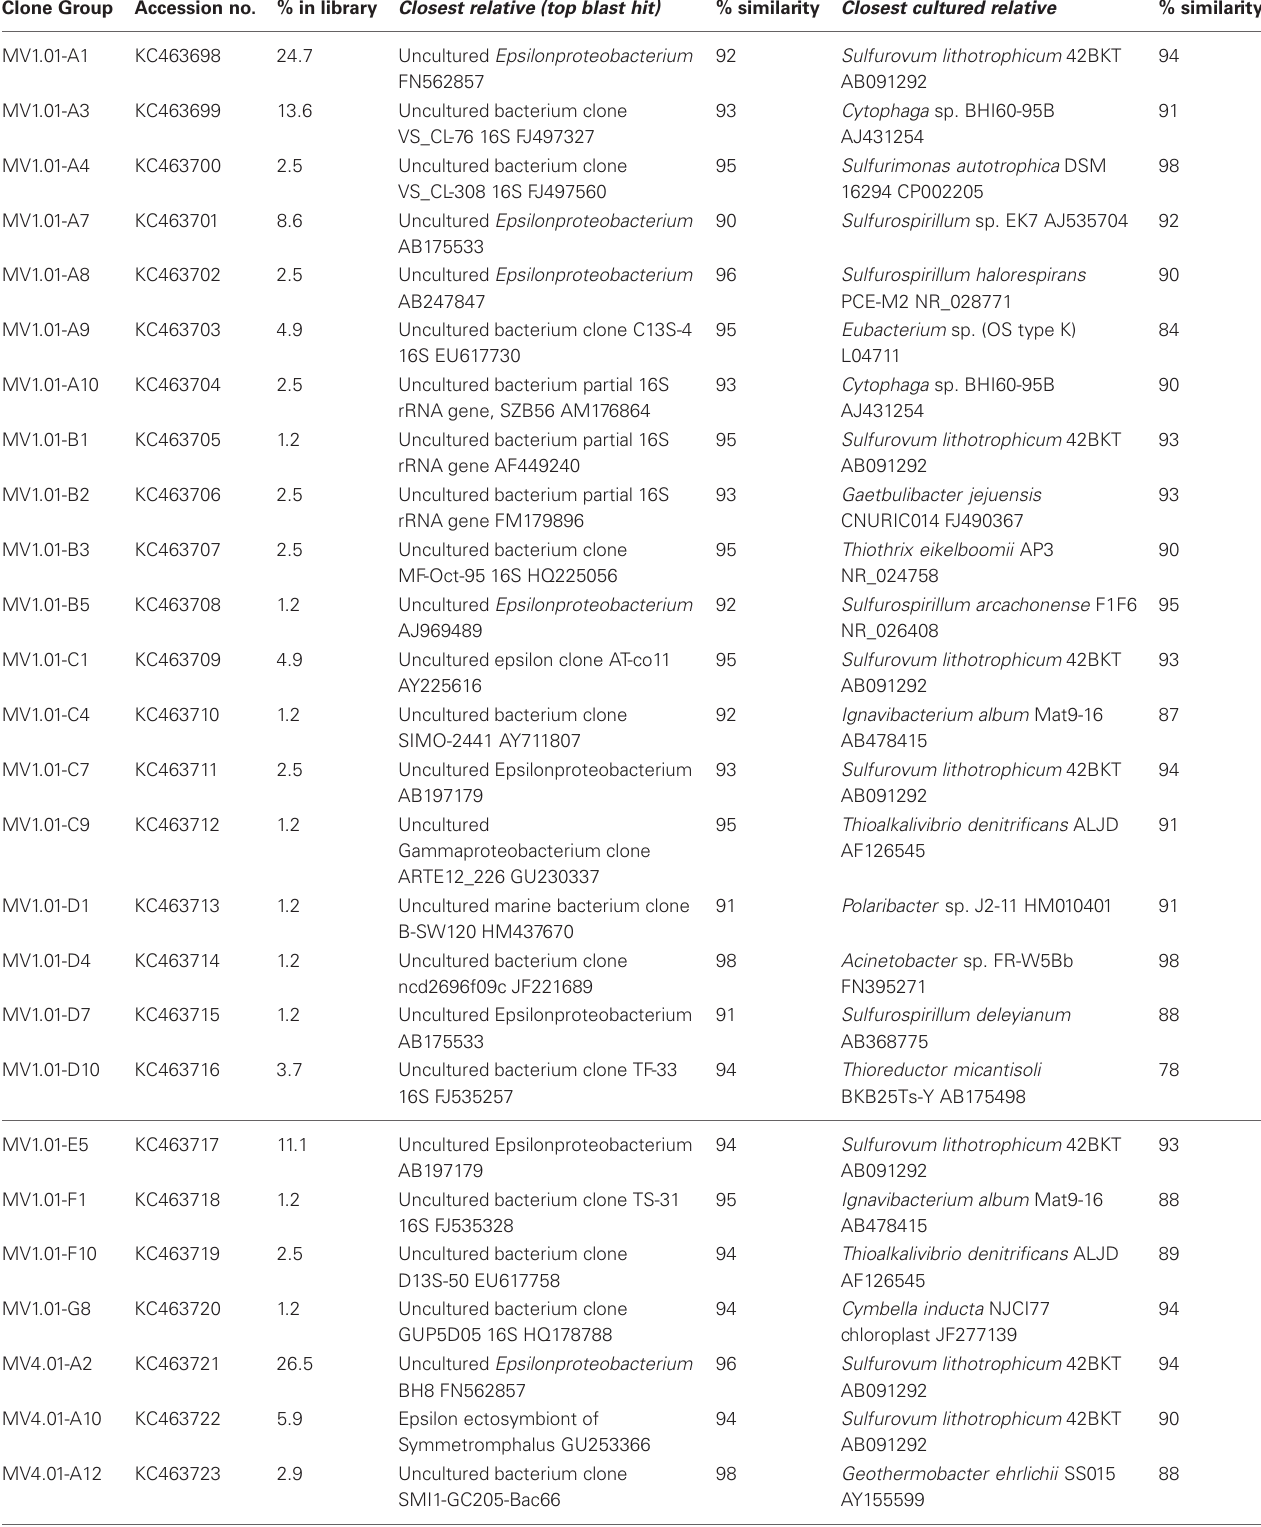
Table 2 | Sequenced clones, top blast hits to the non-redundant database (closet relative) and best hit among cultured bacteria (closest cultured